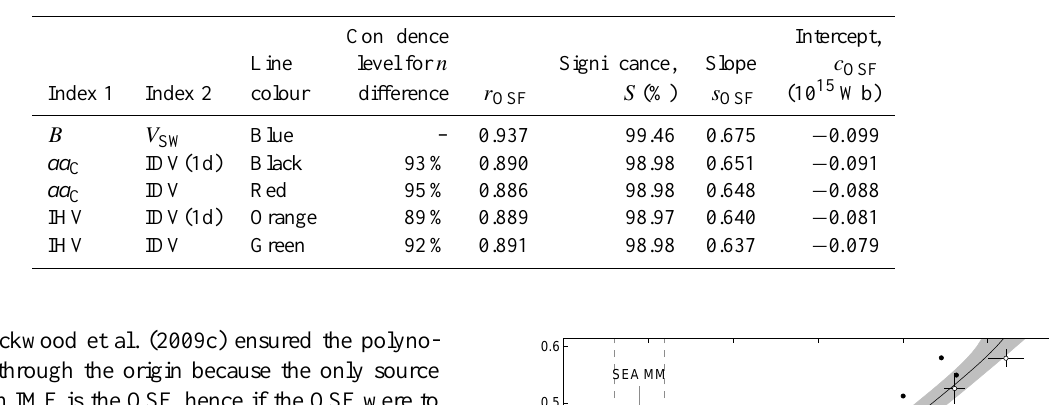
Table 2. The correlations and best fit linear regression coefficients between OSF values derived from Eqs. (4) and (5) from geomagnetically reconstructed B and V SW , but uncorrected for excess flux ( E = 0) with kinematically corrected OSF values from in situ observations. The top line is for in situ data, treated in the same way as the geomagnetic reconstructions.